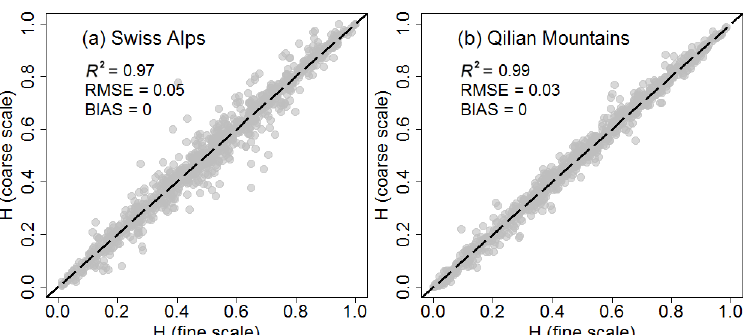
Figure B2. Comparison of hypsometric position derived from coarse-scale (15arcsec) and fine-scale (3arcsec) DEMs based on a random sample of 1000 points.